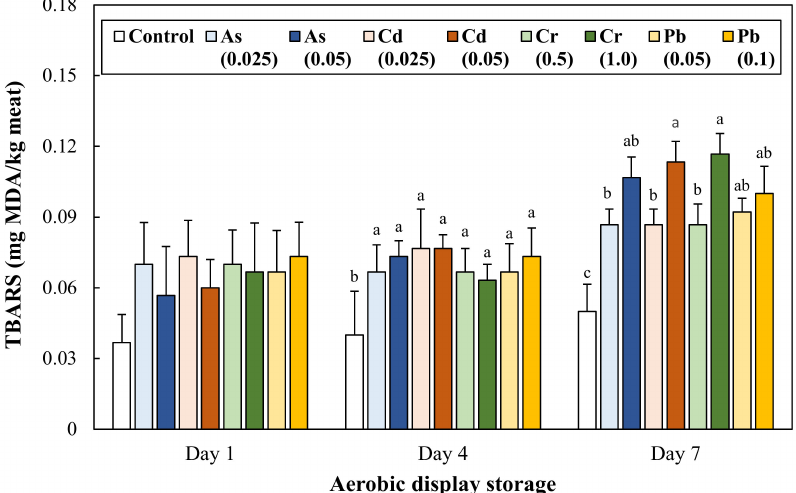
Figure 3. Change in 2-thiobarbituric acid reactive substances (TBARS) of ground pork intentionally contaminated with toxic heavy metals during 7 days of aerobic display storage. The number in parentheses in legend indicates the target concentration (mg/kg) of each heavy metal in ground pork. Error bars represent each standard error (S.E.). The letters a–c represent results that are not significantly different from each other within each display storage ( p ≥